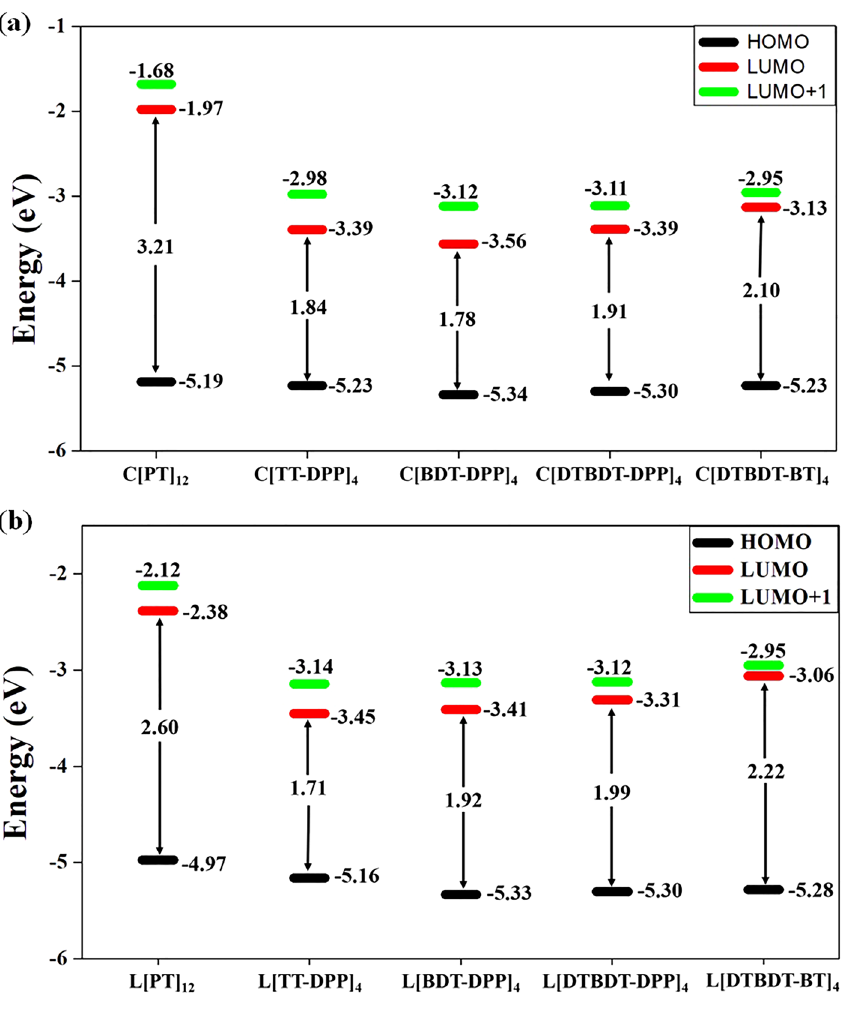
Figure 4. Calculated HOMO and LUMO energy levels of ( a ) cyclic (C[PT] 12 , C[TT-DPP] 4 , C[BDT-DPP] 4 , C[DTBDT-DPP] 4, and C[DTBDT-BT] 4 ) and ( b ) linear (L[PT] 12 , L[TT-DPP] 4 , L[BDT-DPP] 4 , L[DTBDT-DPP] 4, and